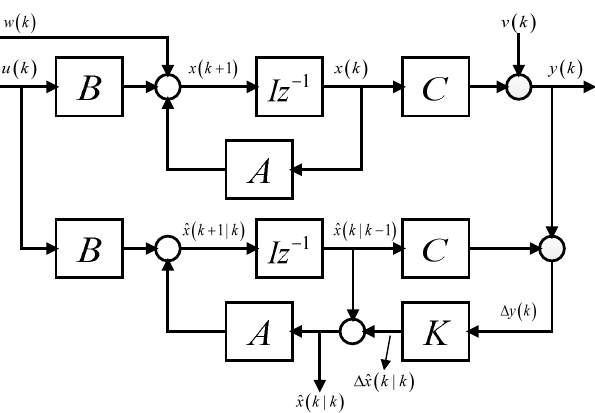
Figure A1. Kalman filter block